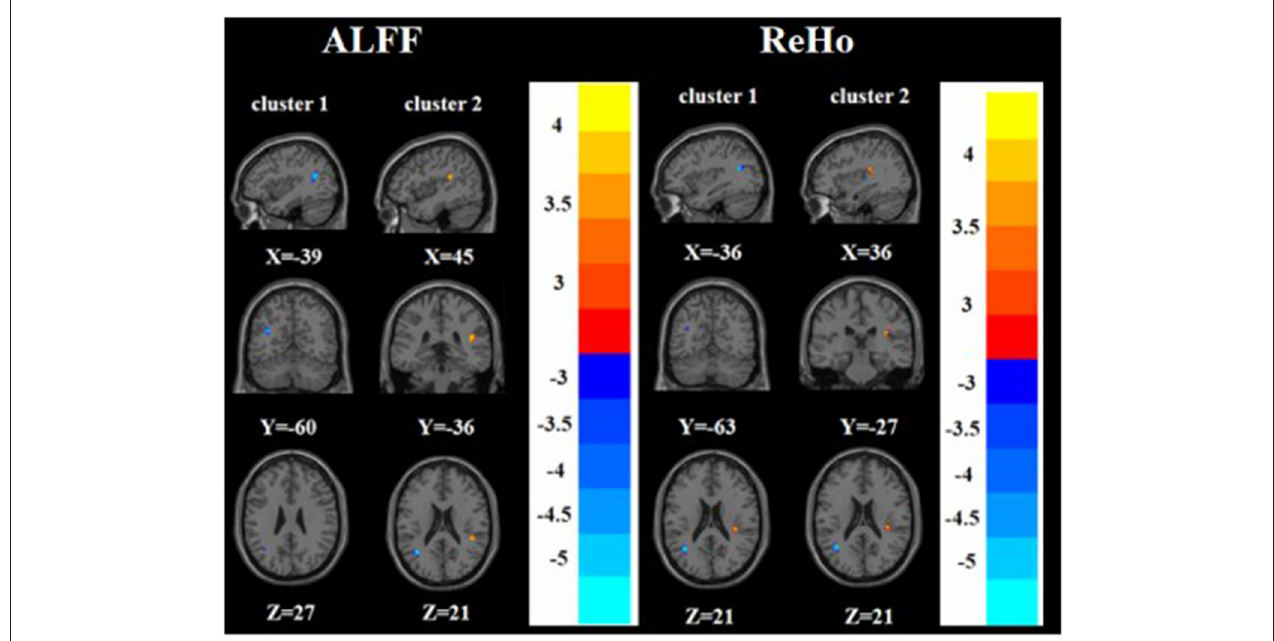
FIGURE 5 | Brain regions with abnormal ALFF (left) and ReHo (right) between nTRD group and HC group based on post hoc T -tests. The color bars indicate the T -value.